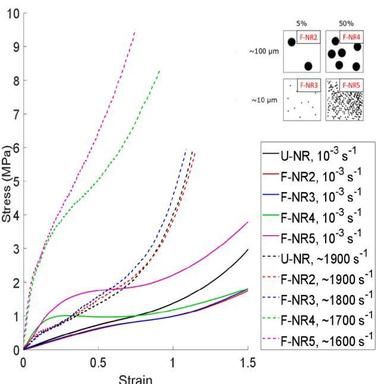
Highlighting selected varying strain rate data for all grades of NR.